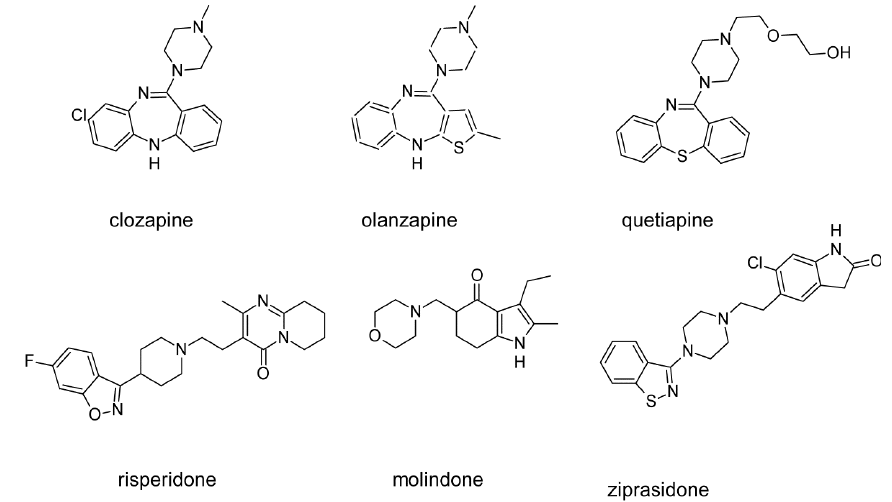
Figure 2. Examples of marketed multi-target second generation antipsychotics [1].